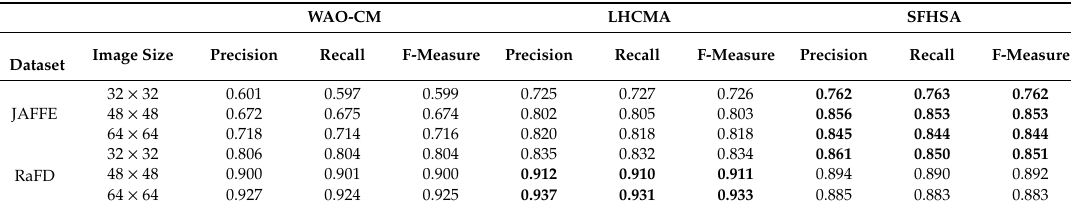
Table 12. Performance of SFHSA with respect to WAO-CM and LHCMA for PHOG features in terms of Precision, Recall and